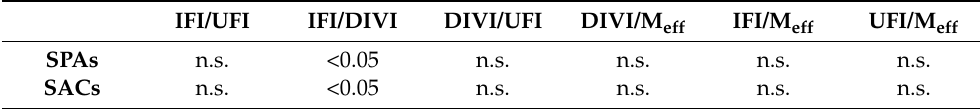
Table 4. Significance ( p value) of the relationships studied. IFI/UFI IFI/DIVI DIVI/UFI DIVI/M eff IFI/M eff UFI/M eff SPAs n.s. <0.05 n.s. n.s. n.s. n.s. SACs n.s. <0.05 n.s. n.s. n.s. n.s.